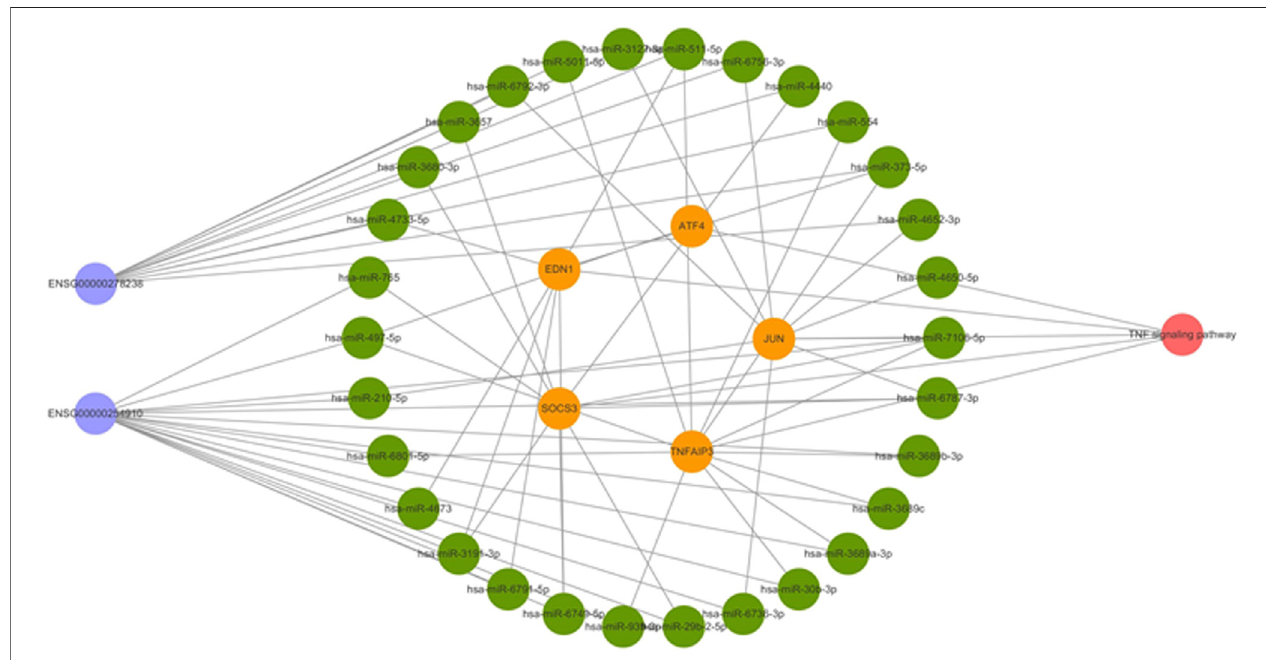
FIGURE 4 | Competing endogenous RNA network in AS. The ceRNA network is based on lncRNA – miRNA – mRNA interactions. Blue represents lncRNAs, green represents miRNAs, yellow represents mRNAs, and red represents the signaling pathway.